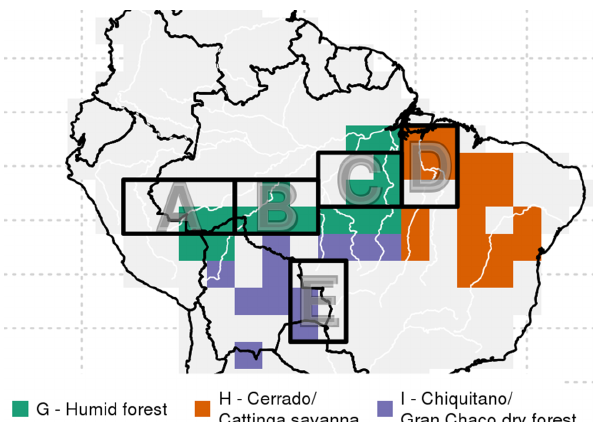
Figure A2. Study regions. Boxes mark areas used for time series in Fig. 1 and rows A–E in Table 1. Coloured areas for time series if Fig. 2 and F–I in Table 1, with the entire coloured region being used for F AAD. See Fig. S4 for construction of AAD and areas